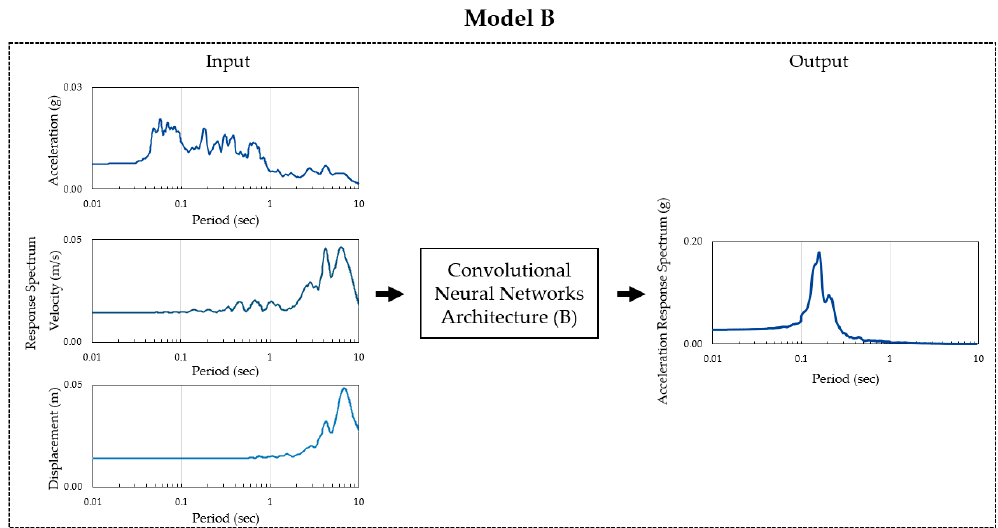
Figure 7. Overview of model B.